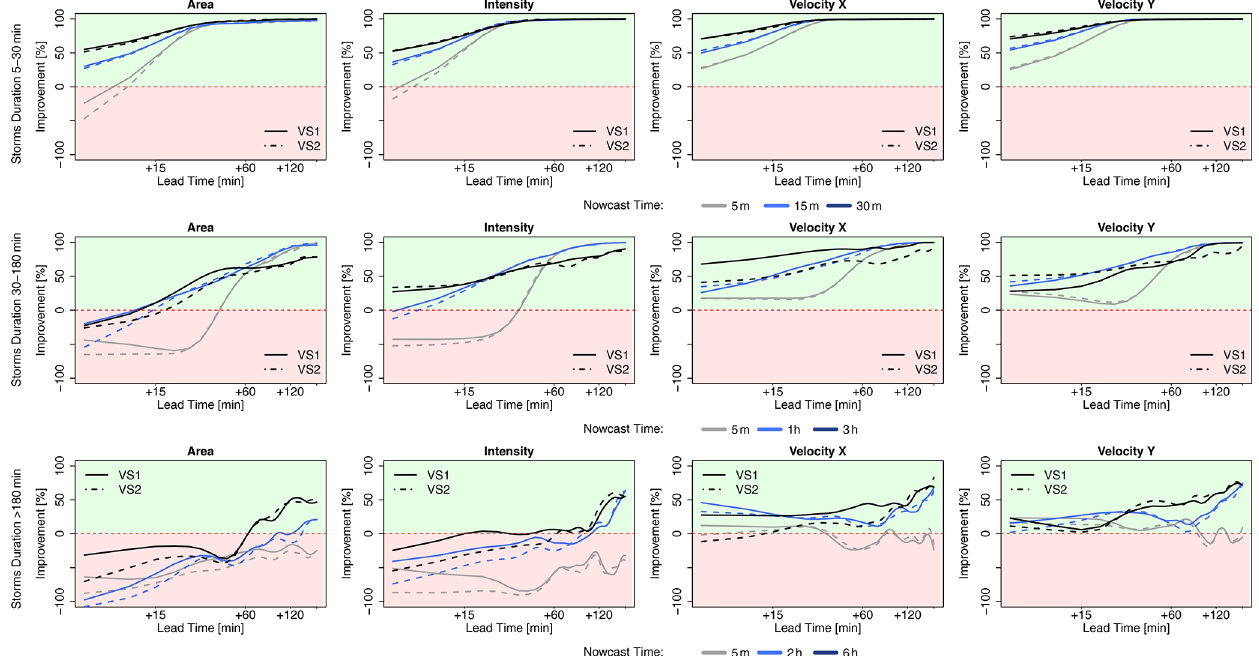
Figure 13. The median improvements over all events that the 30NNs nowcast can introduce into the nowcast of the target variables (area, intensity, and velocity in the x and y directions) in comparison to the Lagrangian persistence. The results are shown for each 30NNs application, VS1 in solid and VS2 in dashed lines, and are calculated separately for storms that last for less than 30min (upper row), less than 3h (middle row) and more than 3h (lower row) and for the respective nowcast times. The green region of the plot indicates a positive improvement (better nowcast by the 4-NN application) and the red region indicates a deterioration (better nowcast by the Lagrangian persistence).